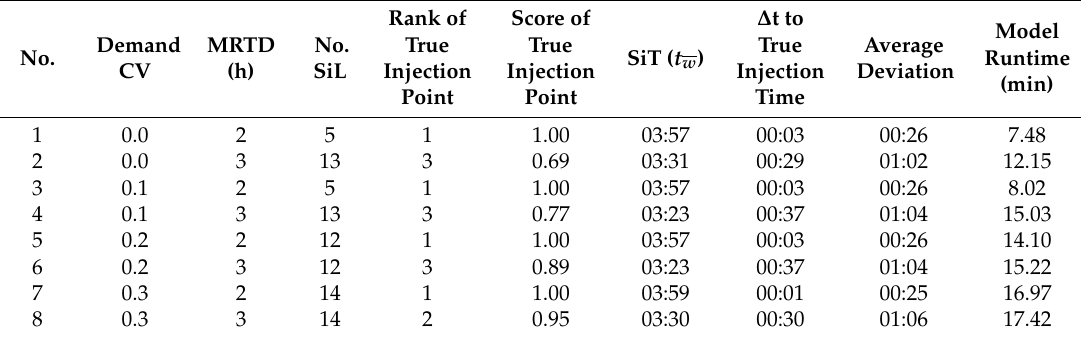
Table 10. Sensitivity analysis of water flow and sensor report